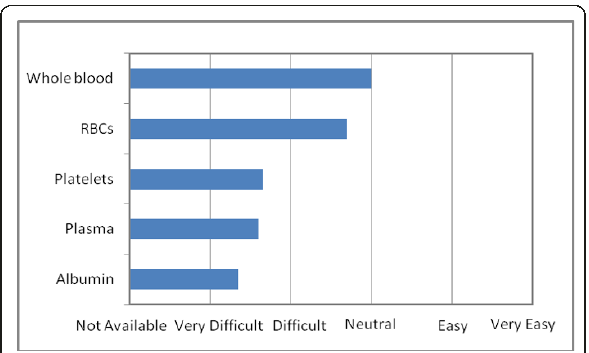
Figure 6 Ease of accessibility of blood products